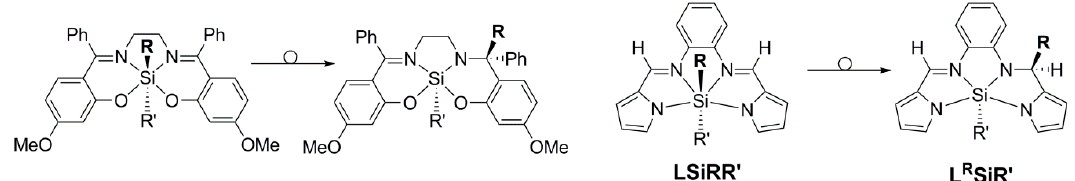
Scheme 4. UV induced rearrangement of an Si-bound hydrocarbyl group in hexacoordinate Si complexes (migration to an imine C atom) observed for complexes of salen-type ligands ( left ) and calculated to be thermodynamically allowed for the herein reported diarylsilicon complexes LSiRR ′ ( right ). Rearrangement energies calculated for the following combinations R,R ′ are: Ph,Ph: − 34.1